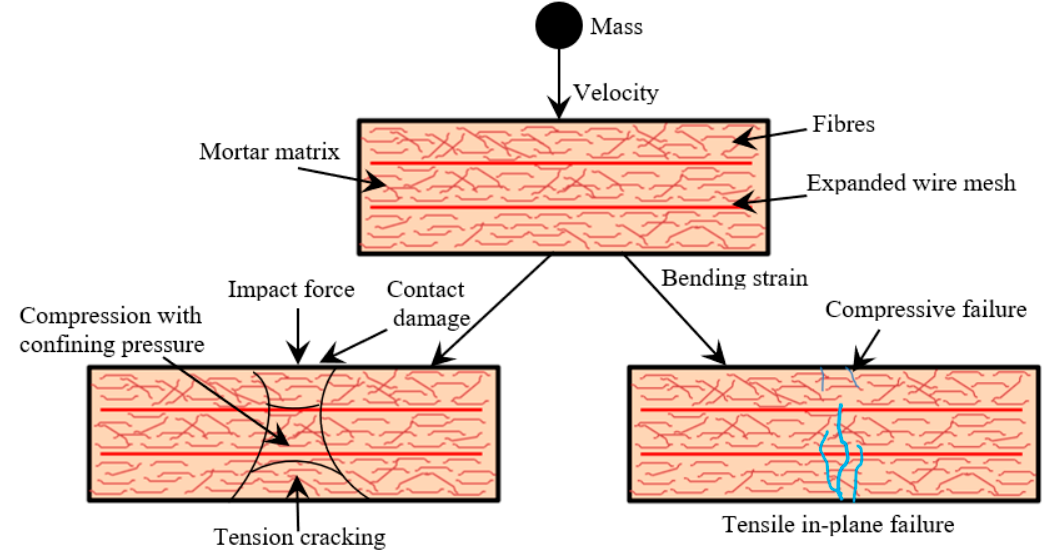
Figure 15. Schematic description of activated failure mechanism under the repeated falling mass impact.